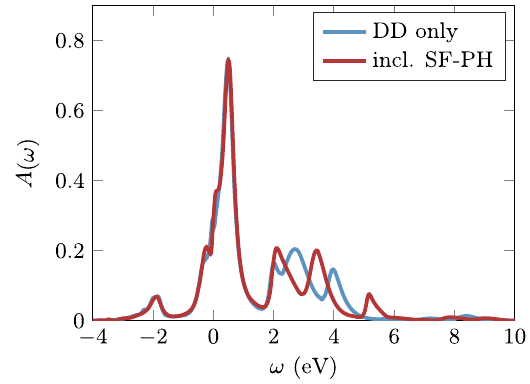
FIG. 3. Spectral functions A ð ω Þ for density-density interactions (DD) only (blue line), and with spin-flip and pair-hopping terms included (red line). In both calculations, we used U ¼ 4 . 0 eV and J ¼ 0 . 6 eV. Both spectra show a three-peak structure in the upper Hubbard band and additional features at high energies (around 8